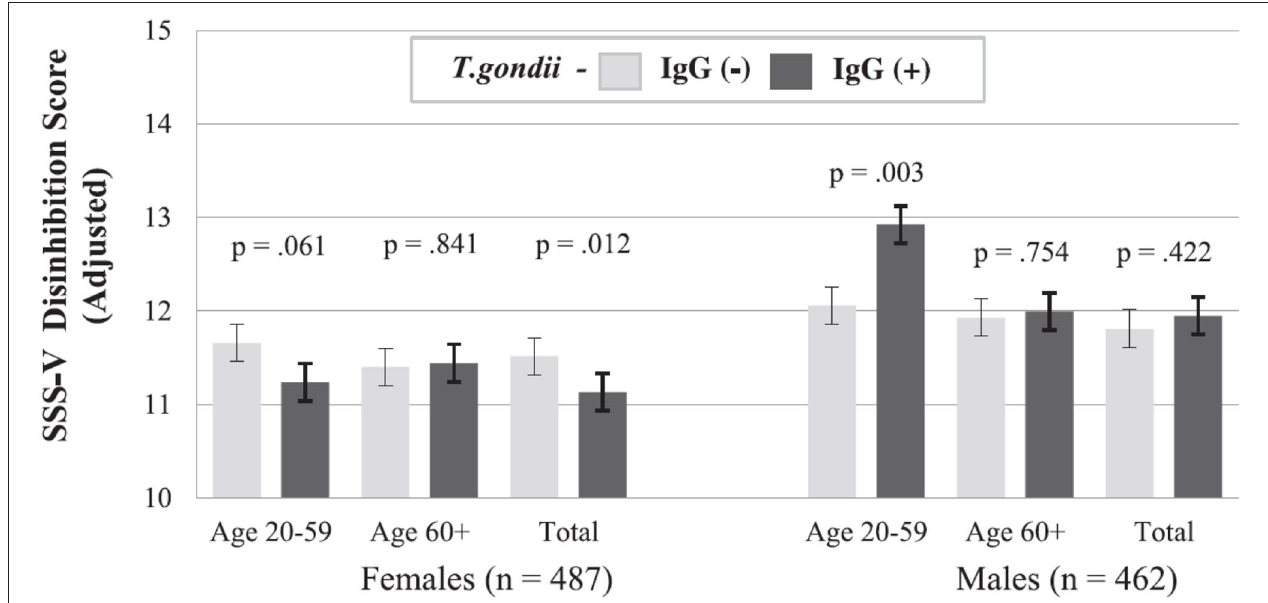
FIGURE 5 | Trait Impulsivity (SSS-V Disinhibition) by Age, Sex, and T. gondii IgG Status ( N = 949). Among younger men aged 20–59 years old, T. gondii seropositivity was significantly associated with higher impulsive sensation-seeking (SSS-V Disinhibition) ( p < 0.01). The two age groups are separated by median age (60 years). T. gondii IgG (–), T. gondii IgG seronegative, T. gondii IgG + , T. gondii IgG seropositive, SSV = Sensation Seeking Scale-V [Reprinted with permission from ( 114); Copyright (2015); with permission from Elsevier; License #